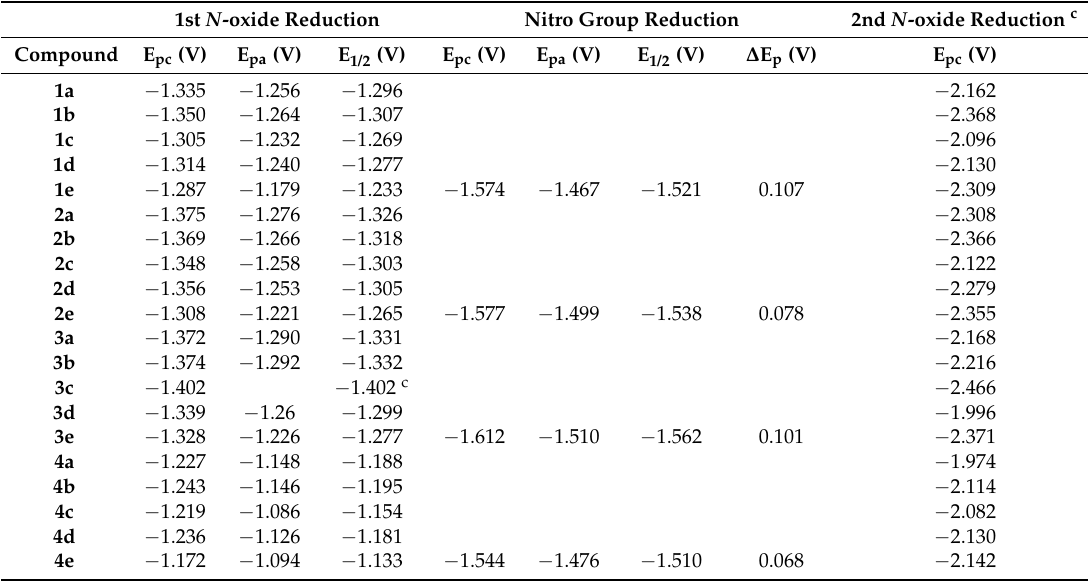
Table 3. First derivative voltammetric data of the 3-aryl-quinoxaline-2-carbonitrile 1,4-di- N -oxide derivatives a,b